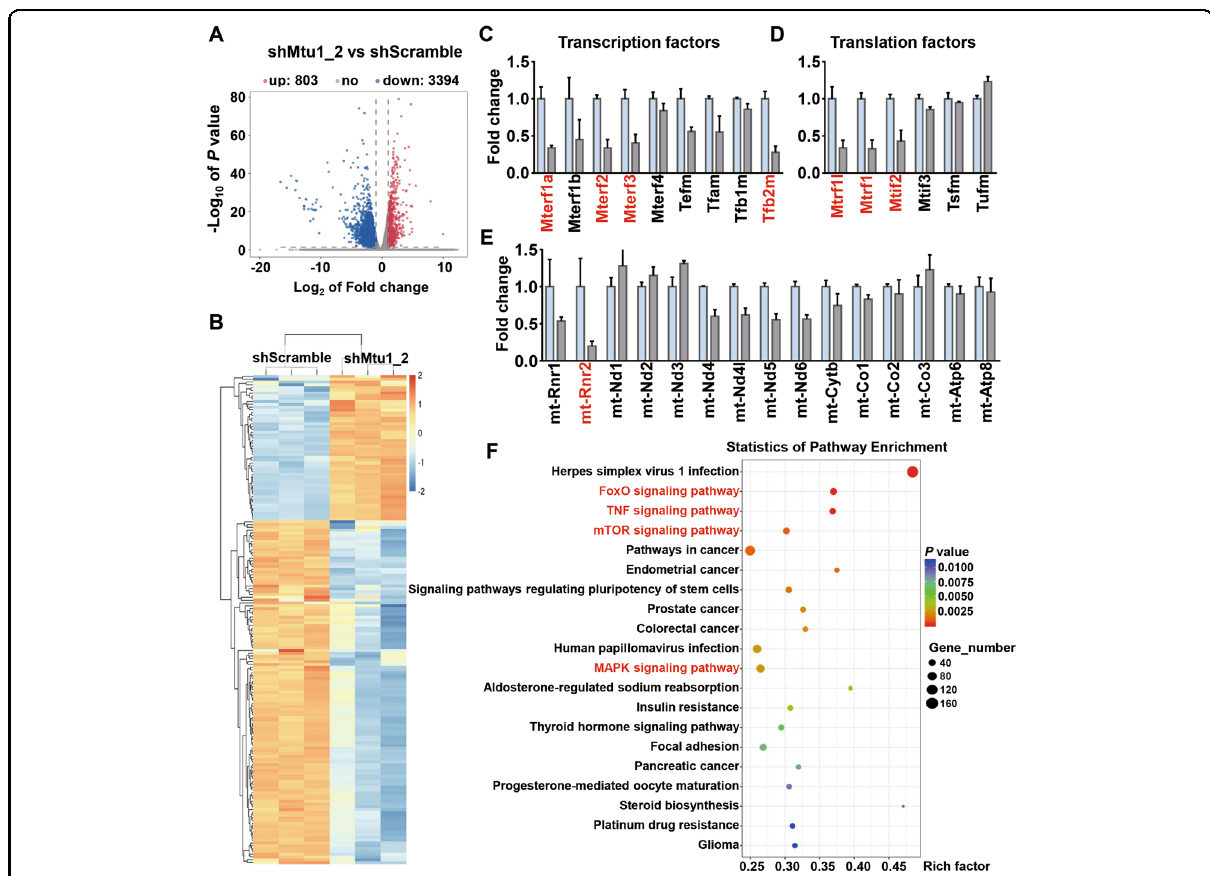
Fig. 6 RNA-seq analysis. A Volcano plot of differentially expressed genes between shScramble and shMtu1_2 cells. Downregulation and upregulation are shown in blue and red dot, respectively, n = 3 per group. B Heat map of 174 altered mitochondrial related genes. C – E The fold changes of mitochondrial transcription factors ( C ), mitochondrial translation factors ( D ), and mitochondrial DNA encoded transcripts ( E ). Genes marked in red color indicate statistically signi fi cant ( P < 0.05) by R package – Ballgown and log 2 (fold change) > 1 or log 2 (fold change) < − 1. F KEGG analyses of RNA-seq data showing the top 20 regulated pathways in Mtu1_2 cells, compared with shScramble cells. P values were shown by different color, the size of bubble indicate the gene count of each